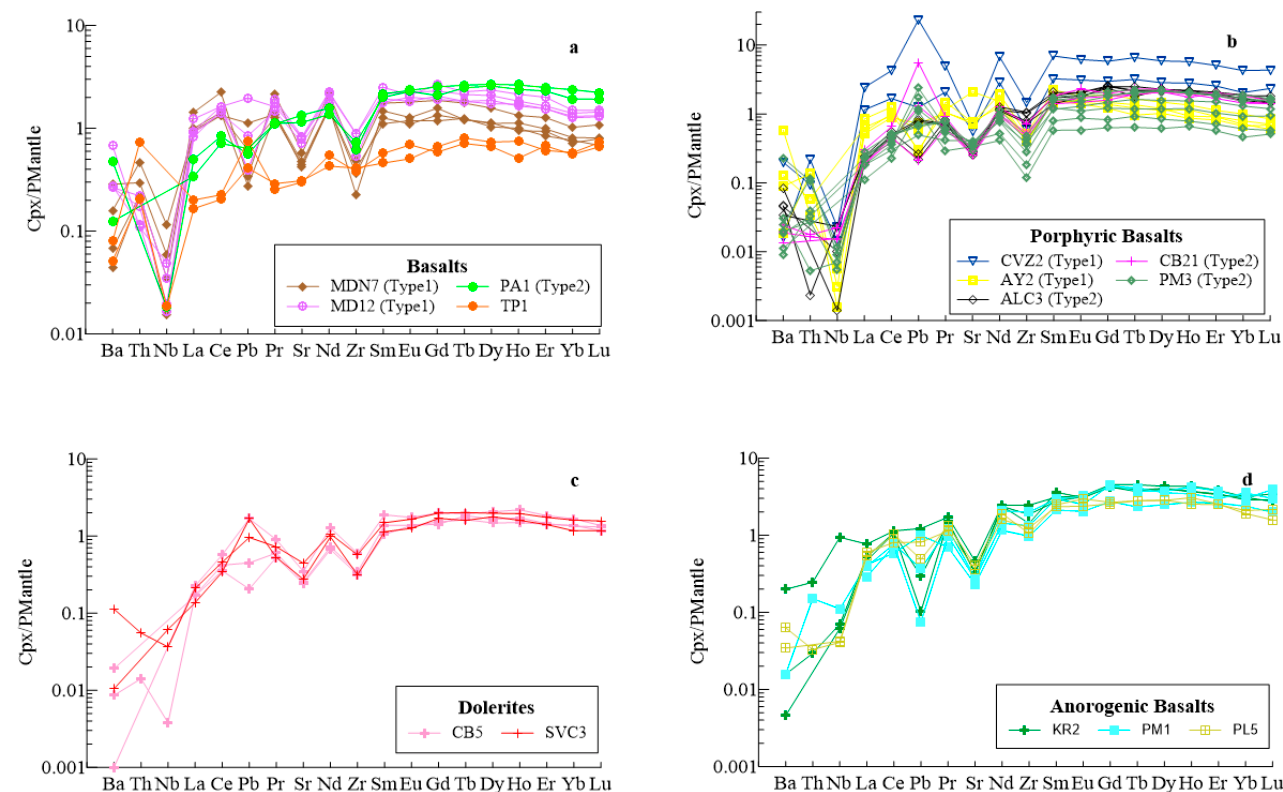
Figure 8. Primitive mantle-normalized multi-element variation diagrams of the clinopyroxene phe- nocrysts from the Yüksekova Complex (Normalizing values are from [53]). ( a ) Basalts; ( b ) Porphyric basalts; ( c ) Dolerites; ( d ) Anorogenic basalts.